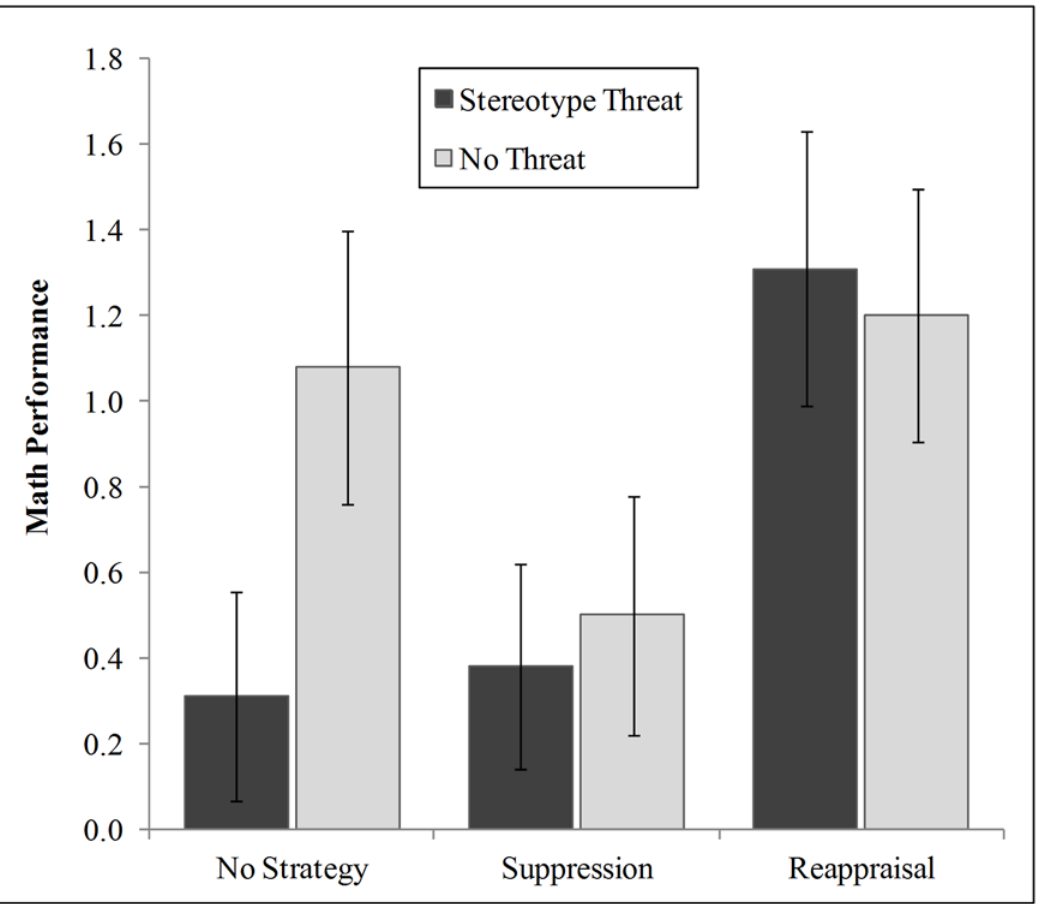
Fig 1. Group Means and Standard Deviations of Math Test Performance. N = 113. Numbers at the bottom of the columns are the coefficients of the significant focal contrast. The non-significant orthogonal contrasts were (0 -1 0 1 0 0), (-1 0 0 0 2 -1), (-1 0 0 0 0 1), and (0 -1 2 -1 0 0). The means and standard deviations are, from left to right: M 1 = 0.29, SD 1 = 1.01, M 2 = 1.08, SD 2 = 1.40, M 3 = 0.38, SD 3 = 1.02, M 4 = 0.50, SD 4 = 1.22, M 5 = 1.29, SD 5 = 1.40, SD M 6 = 1.20, 6 =